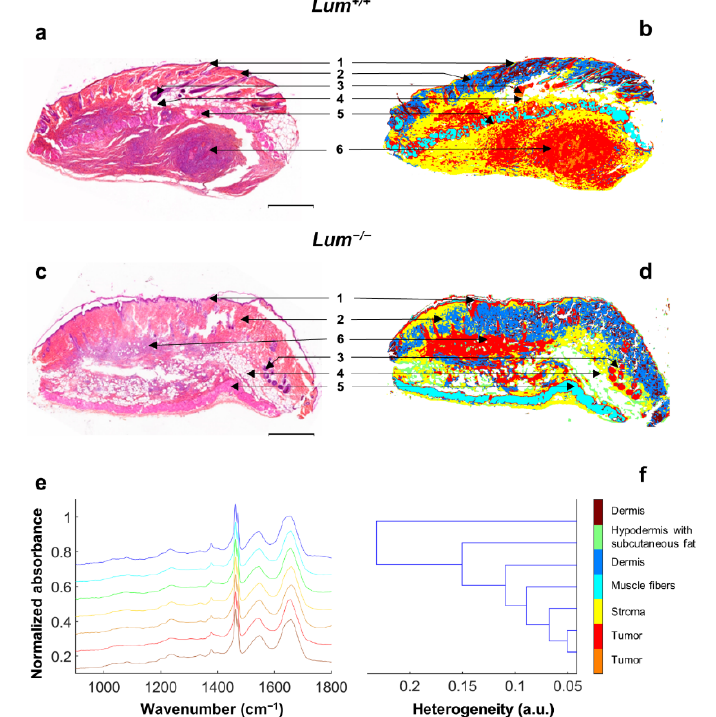
Figure 5. K-means clustering of FTIR spectral images of ovarian tumor sections in wild-type and lumican-deficient mice. ( a , c ) Example of s.c. allograft whole sections stained with HES (original magnification 20× scale bar 500 µm) in Lum +/+ ( a ) and Lum − / − mice ( c ); ( b , d ) Representative color- coded K-means (7 classes) clustered images of tumor sections in Lum +/+ ( b ) and Lum − / − mice ( d ) (1: epidermis, 2: dermis, 3: hair bulb, 4: hypodermis, 5: smooth muscle, 6: tumor); ( e ) EMSC-corrected